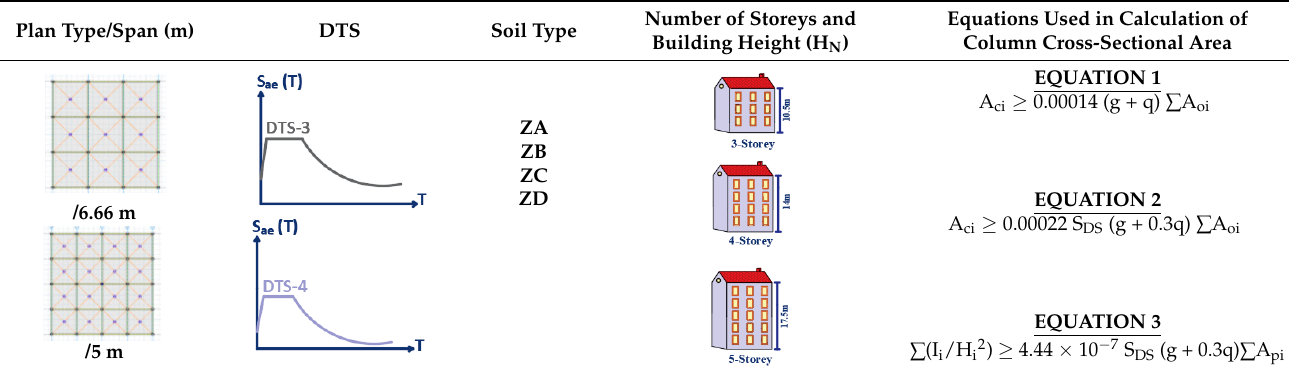
slabs with beams was chosen as 15 cm. Table 3 shows the beam reinforcement values calculated according to the code’s relevant section reinforcement lower